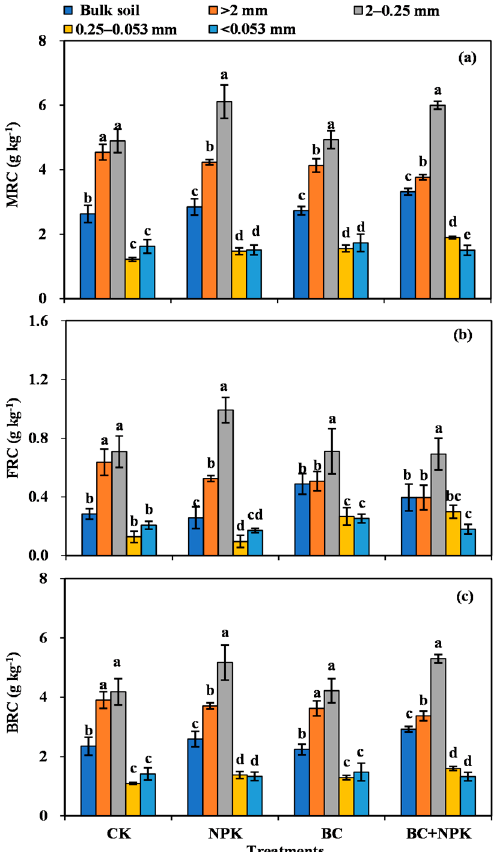
Figure 2. Contents of microbial residue carbon, fungal residue carbon, and bacterial residue carbon in bulk soil and aggregates among different treatments ( a – c ). Error bars are the SD of mean from three duplicates. Diverse lowercase letters denote significant differences ( p < 0.05) among different particle sizes. Abbreviations: MRC, microbial residue carbon; FRC, fungal residue carbon; BRC, bacterial residue